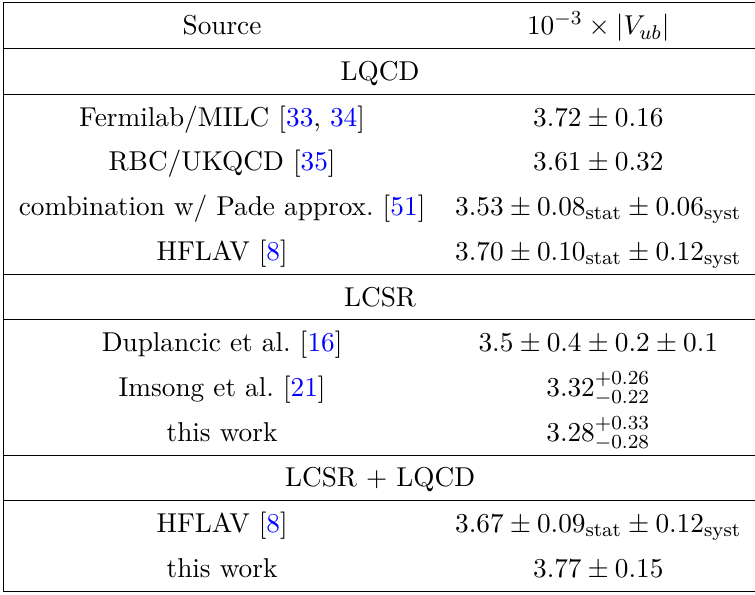
Table 8 . Comparison of the | V ub | CKM matrix element determinations from the ¯ B → π‘ − ¯ ν ‘ decays, using QCD-based form factor predictions.